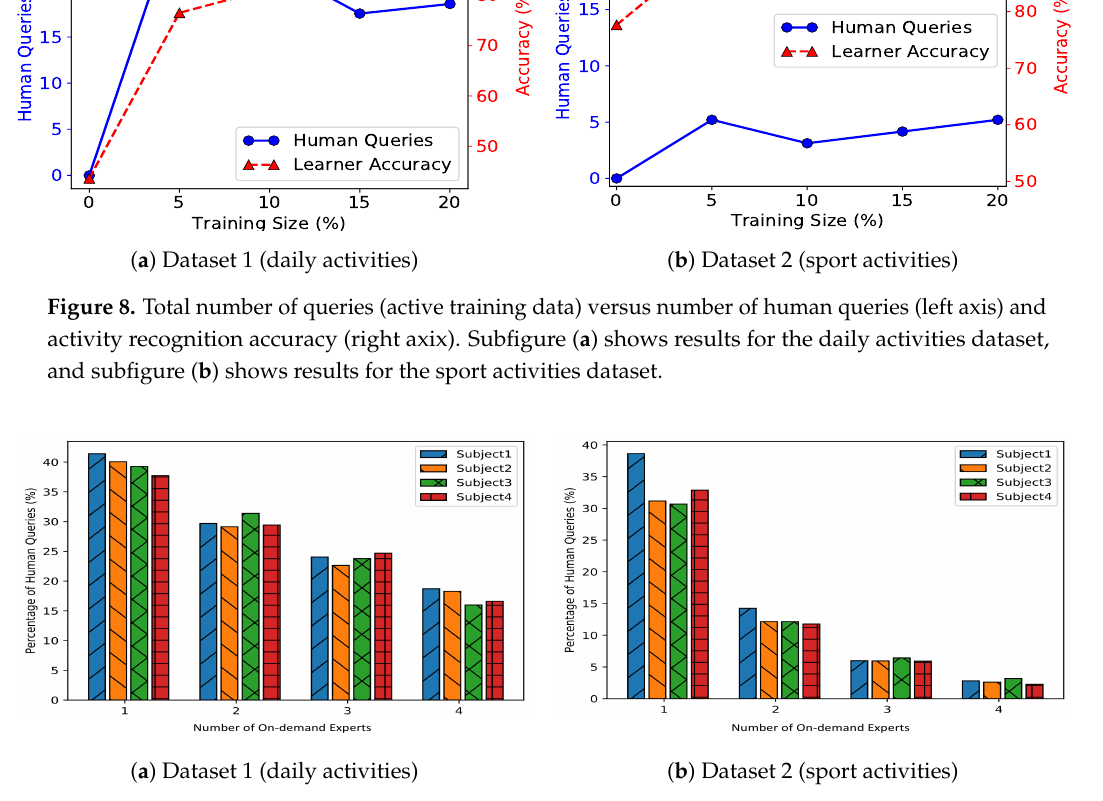
Figure 9. Number of on-demand experts versus number of queries from human